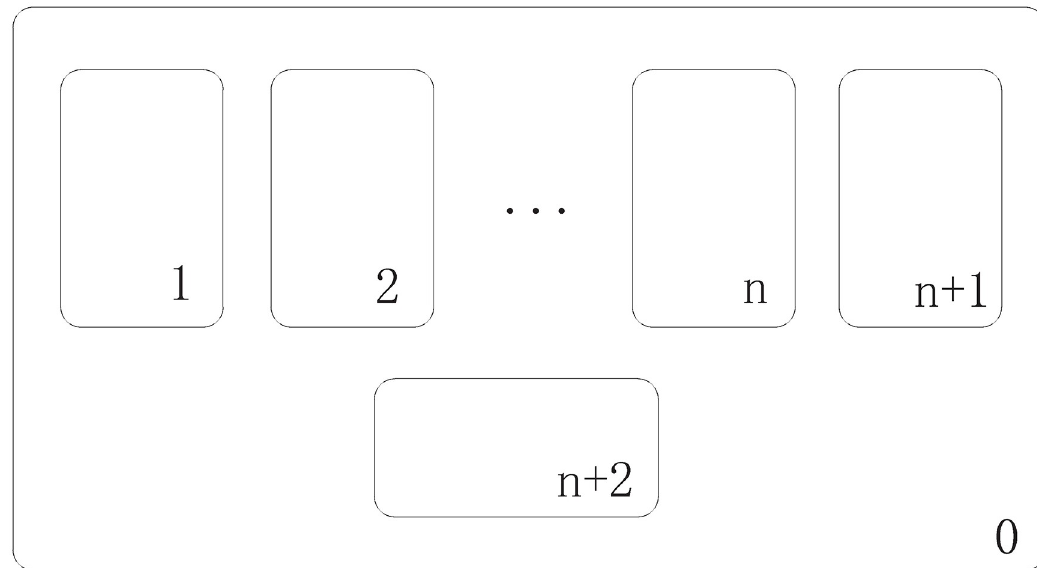
Fig 1. Membrane structure for the improved DBSCAN